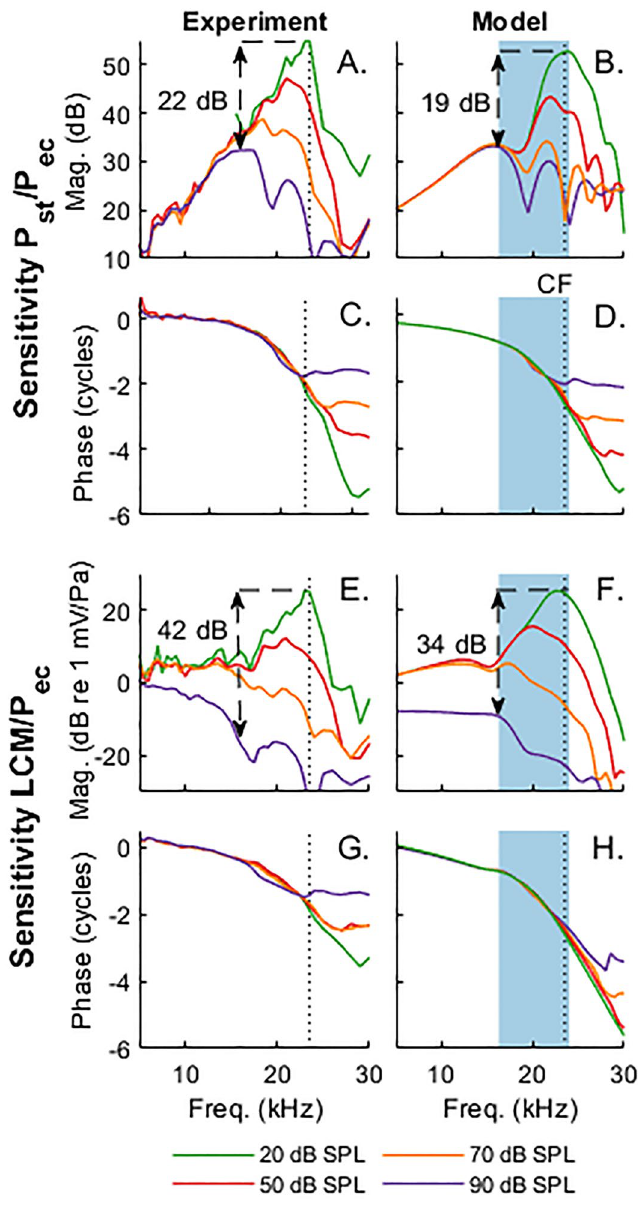
Figure 2. Comparison of animal experiments (left column, animal wg182) and model simulations (right column) for the mechanical (ST pressure) and electrical (local cochlear microphonics, LCM) responses of the cochlea to pure tone stimuli. In all panels, the vertical dashed line is the BF of 23.5 kHz. ( A–D ) Sensitivity ( A,B ) and phase ( C,D ) of ST pressure relative to EC pressure. ( E–H ) Sensitivity ( E,F ) and phase ( G,H ) of the LCM relative to EC pressure. The blue-shaded area in ( A,D,F,H ) corresponds to the frequency range where OHCs deliver significant power to the BM in response to 20 dB SPL tones. The vertical arrows identify the gain, defined as the ratio of the sensitivity at the BF at 20 dB SPL and the sensitivity at the frequency of maximum P st sensitivity at 90 dB